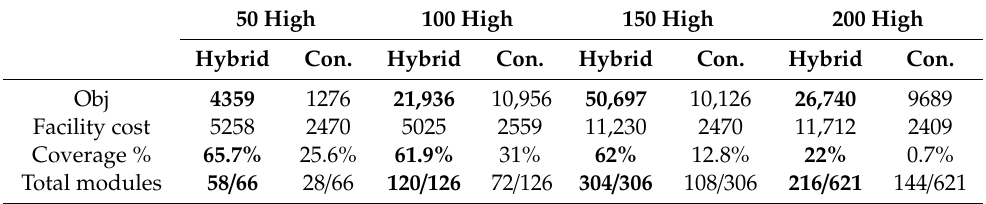
Table 5. Computational results for comparing the performances of hybrid and conventional approaches. The bold is necessary as it shows the performance of the better method. 50 High 100 High 150 High 200 High Hybrid Con. Hybrid